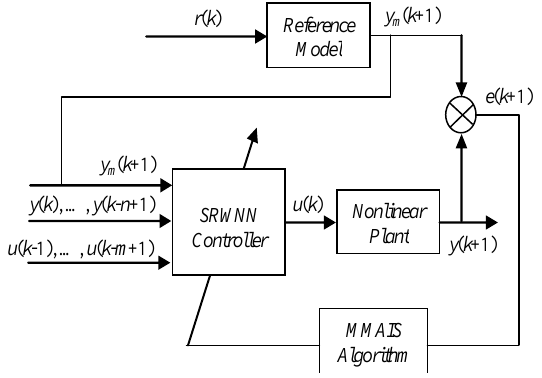
Fig. 1 Structure of the SRWNN- based MRAC system.